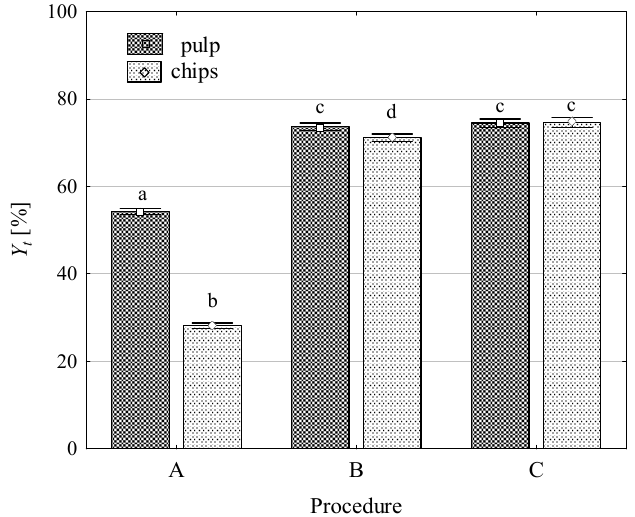
Figure 3. Impact of applied procedures on the total yield Y t of pressing juice from ground celeriac root. A—two-stage pressing of pulp; B—two-stage pressing, first pulp, and then pomace after freezing and thawing; C—two-stage pressing, first pulp after freezing and thawing and then pomace after freezing and thawing. a, b, c, and d—average values marked with the same letter show no statistically significant difference ( p ≤ 0.05).